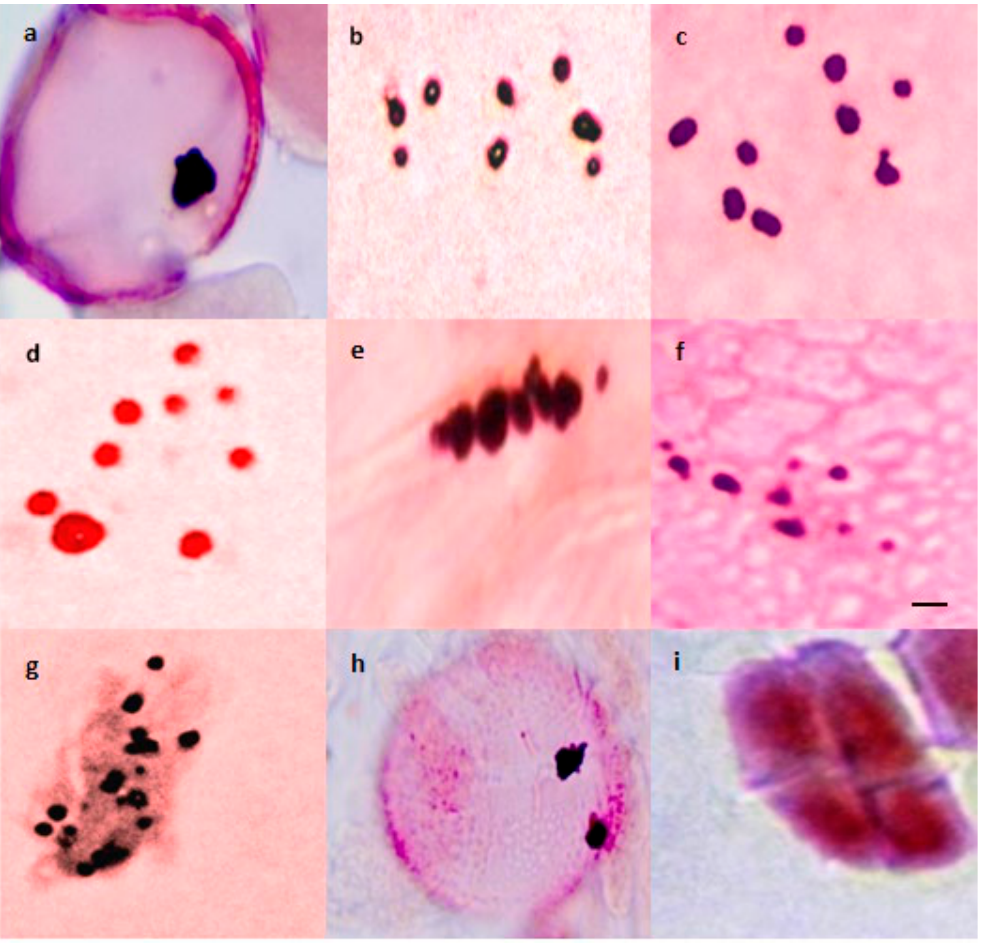
Figure 4. Pollen meiosis in some natural populations of Trifolium subterraneum L. in Algeria L. (a) pollen cell ; (b) Diakinesis (population 22/10, n=x=8) ; (c) Diakinesis (22/10, n=x=9) ; (d) Diakinesis (population 23/10, n=x=8) ; (e) Metaphase I (population 23/10, n=x=8) ; (f) Metaphase I (population 23/10 n=x=9) ; (g) Anaphase I ; (h) Telophase I ; (i) Tetrade. Bar: 2